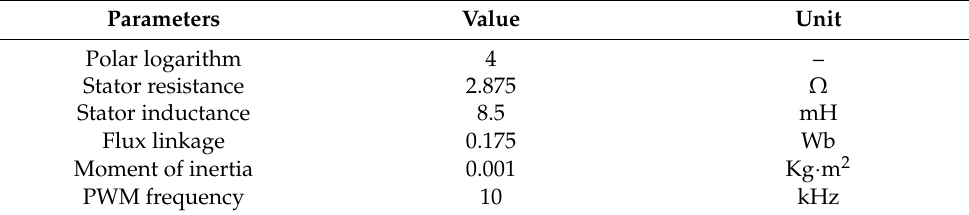
Figure 1. Control block diagram. Table 2. System Parameters.